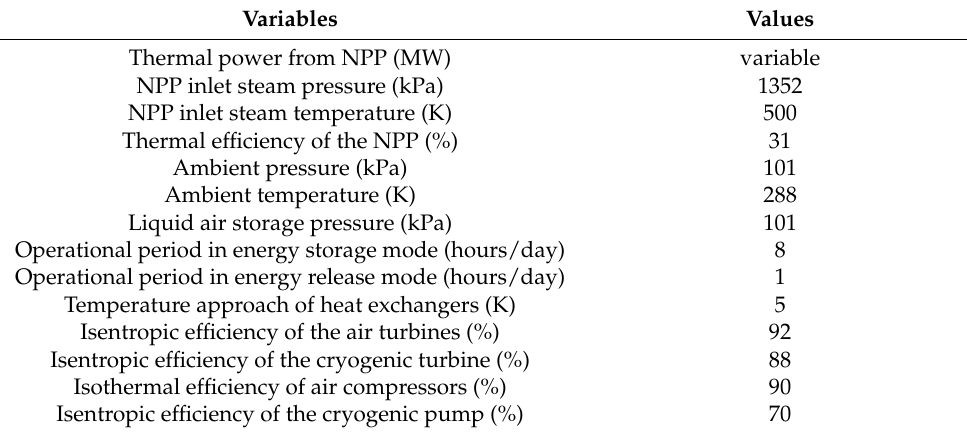
Table 2. Nuclear Power Plant Conditions—APR1400.